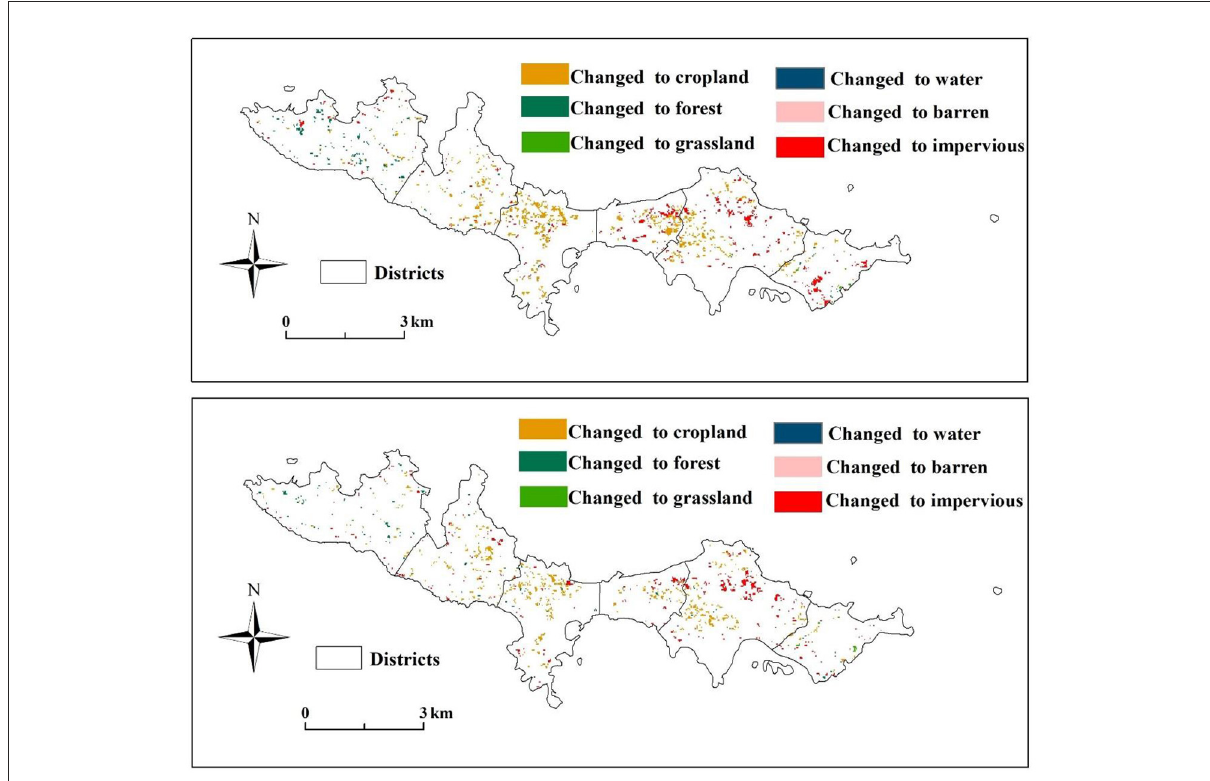
FIGURE6 Land use transfer and change from 2009–2014 and from 2014–2019.